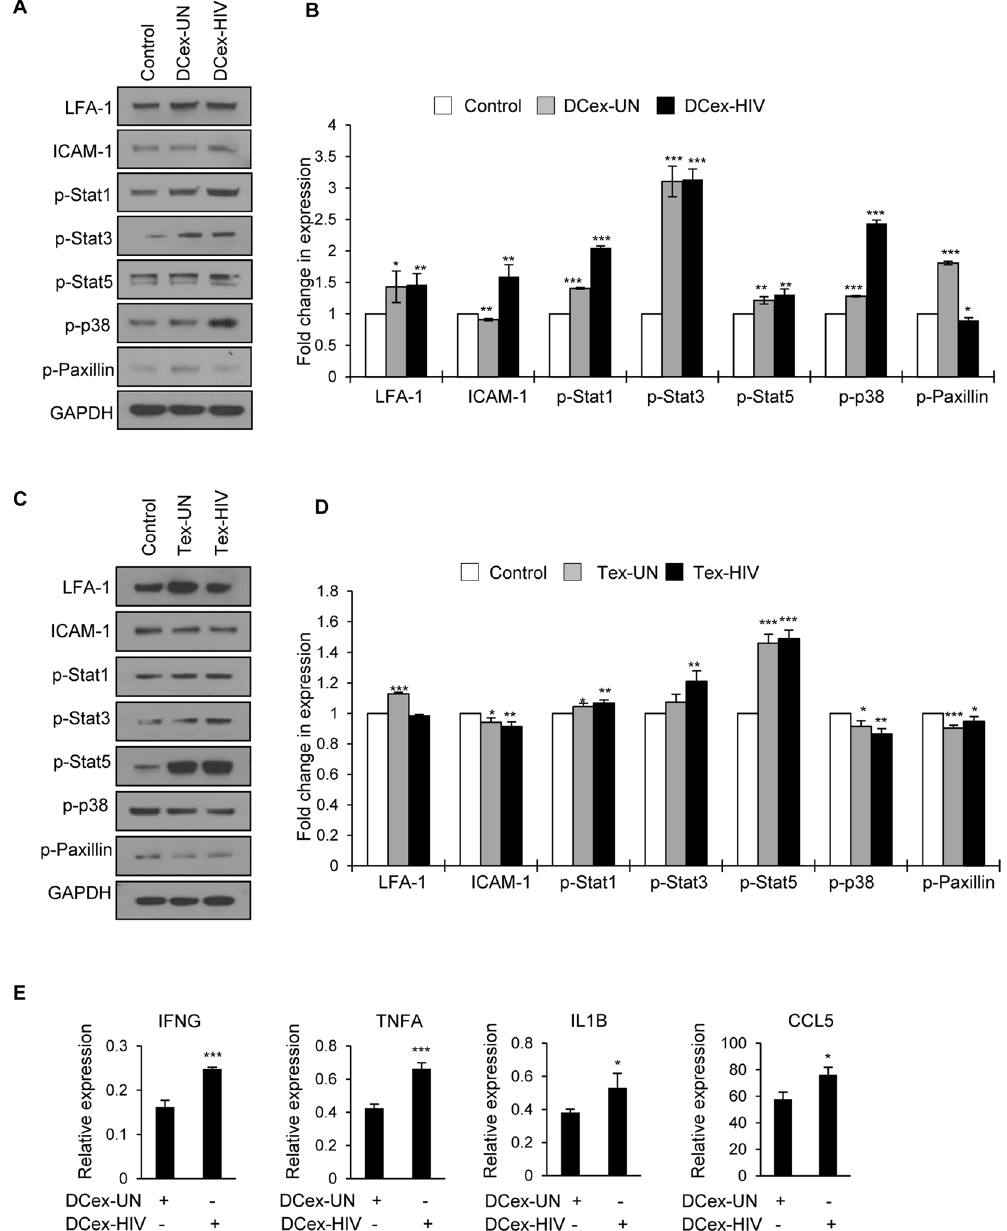
Figure 5. Exosomes derived from HIV-1 infected DCs activated p38/STAT signaling and induced expression of pro-inflammatory cytokines in T cells. ( A ) Representative Western blot images of indicated signaling molecules in T cells incubated with or without (control) exosomes derived from uninfected (DCex-UN) or HIV-1 infected (DCex- HIV) DCs for 24 hours. GAPDH was used as a loading control. Full-length blots are presented in Supplementary Figure S3. ( B ) Quantitative analysis of Western blot images of ( A ); the band intensity of each lane was determined by Image J software and pixel density was calculated by normalizing to control. ( * p ≤ 0.05, ** p ≤ 0.01, *** p ≤ 0.001, p-values for LFA-1 – 0.04053, 0.009804; ICAM-1 – 0.00135, 0.00519; p-Stat1 – 0.0000008, 0.0000006; p-Stat3 – 0.000114, 0.000023; p-Stat5 – 0.0032, 0.00365; p-p38 – 0.0000015, 0.0000014; p-Paxillin – 0.000001, 0.0142). ( C ) Representative Western blot images of indicated signaling molecules in T cells incubated with or without (control) exosomes derived from uninfected (Tex-UN) or HIV-1 infected (Tex-HIV) T cells for 24 hours. GAPDH was used as a loading control. Full-length blots are presented in Supplementary Figure S3. ( D ) Quantitative analysis of Western blot images of ( C ); the band intensity of each lane was determined by Image J software and pixel density was calculated by normalizing to control ( * p ≤ 0.05, ** p ≤ 0.01, *** p ≤ 0.001, p-values for LFA-1 – 0.00002; ICAM-1 – 0.025, 0.0086; p-Stat1 – 0.0222, 0.0047; p-Stat3 – 0.00633; p-Stat5 – 0.00015, 0.000105; p-p38 – 0.016, 0.0028; p-Paxillin – 0.00099, 0.0434). ( E ) qRT-PCR for IFNG, TNFA, IL1B, and CCL5 in T cells incubated with or without DCex-UN or DCex-HIV for 3 days. Relative gene expression of cytokines in T cells incubated with DCex-UN or DCex-HIV. The data represents mean of triplicates ± SE from three independent experiments ( * p ≤ 0.05, ** p ≤ 0.01, *** p ≤ 0.001, p-values for IFNG – 0.000655, TNFA – 0.00073, IL1B – 0.04711, CCL5 –